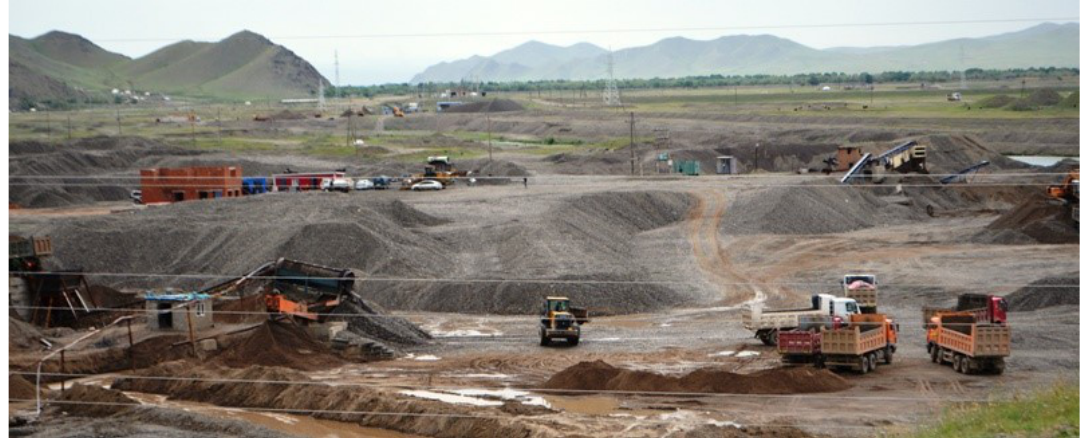
Figure 3. Mining operation in the Tuul River